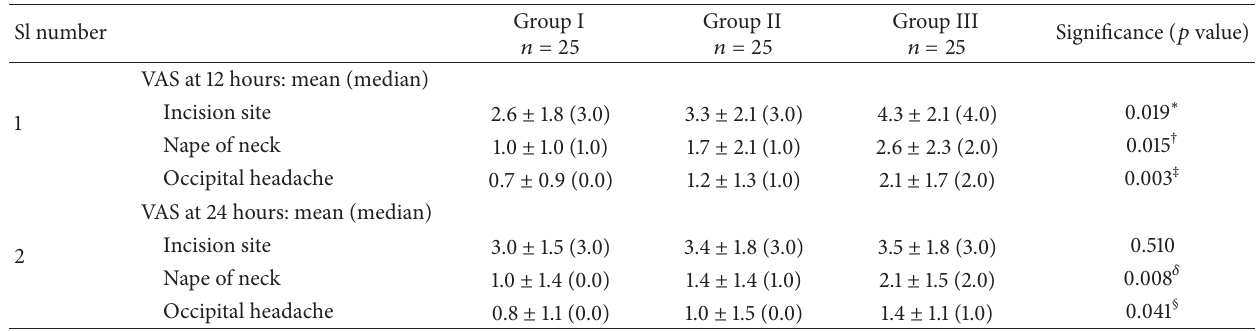
Table 3: Outcome in terms of VAS